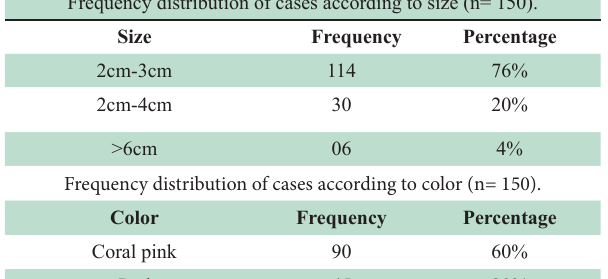
Table-III: Frequency distribution of various cases variable.